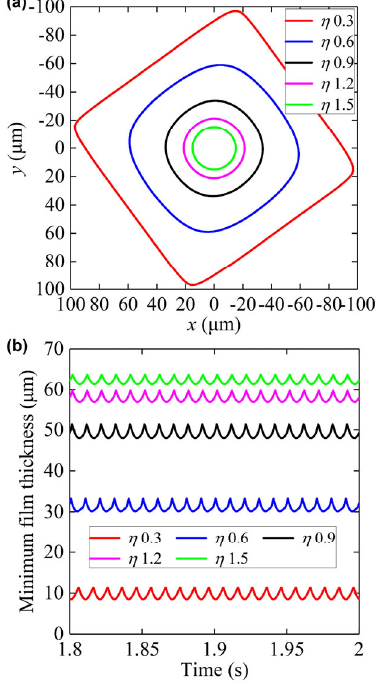
Fig. 8 (a) Journal center orbits and (b) dynamic minimum film thicknesses of a TPJB without static loads for different length- to-diameter ratios.